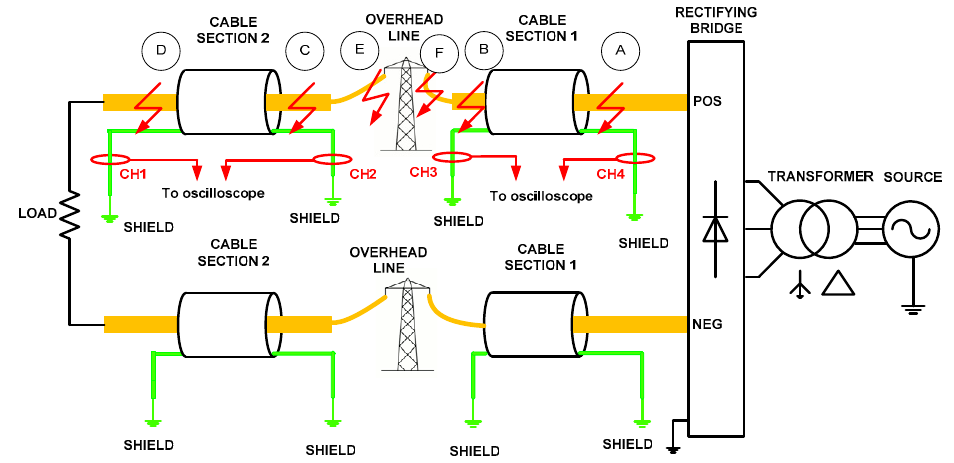
Figure 13. Layout of experimental ground faults positions in the cable side (A, B, C, and D) and in the overhead line side (F and E).